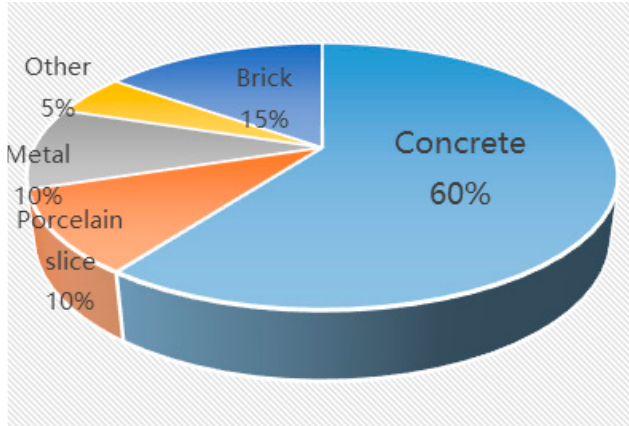
Figure 1. Composition of construction waste.